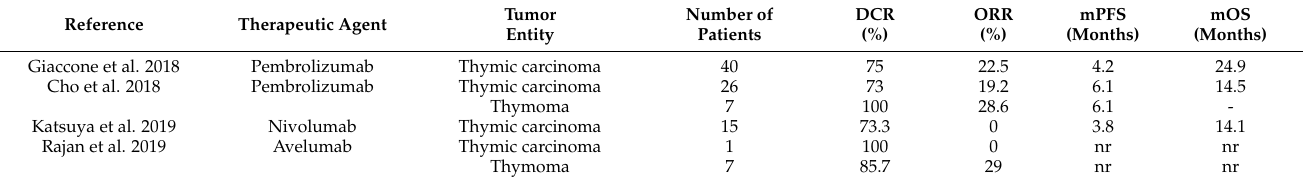
Table 1. Clinical trials evaluating the efficacy of immune checkpoint inhibition in thymic epithelial tumors. ORR = overall response rate, DCR = disease control rate, mPFS = median progression free survival, mOS = median overall survival, nr = not reported, - = endpoint not reached.